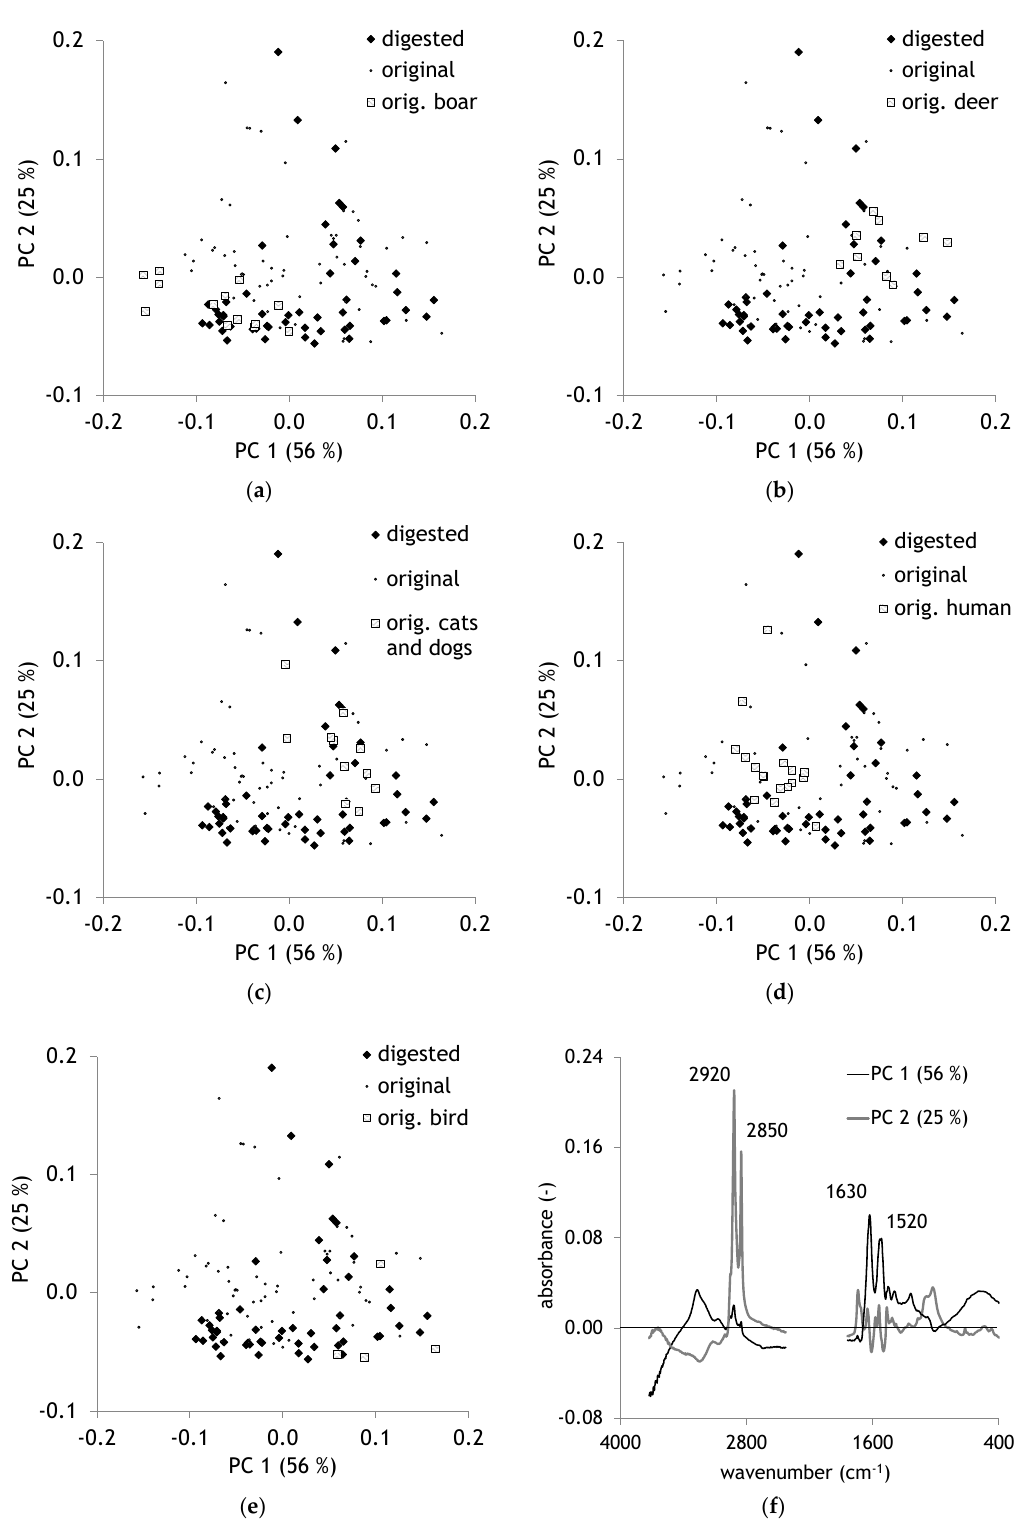
Figure 3. ( a ) Scores plot with highlighted samples of wild boar, ( b ) deer, ( c ) cats and dogs, ( d ) human hair, ( e ) and of bird feathers; ( f ) loadings plot of PCA containing only unground samples, n = 124. The species pattern of digested hairs overlapped the pattern of original hair from di ff erent